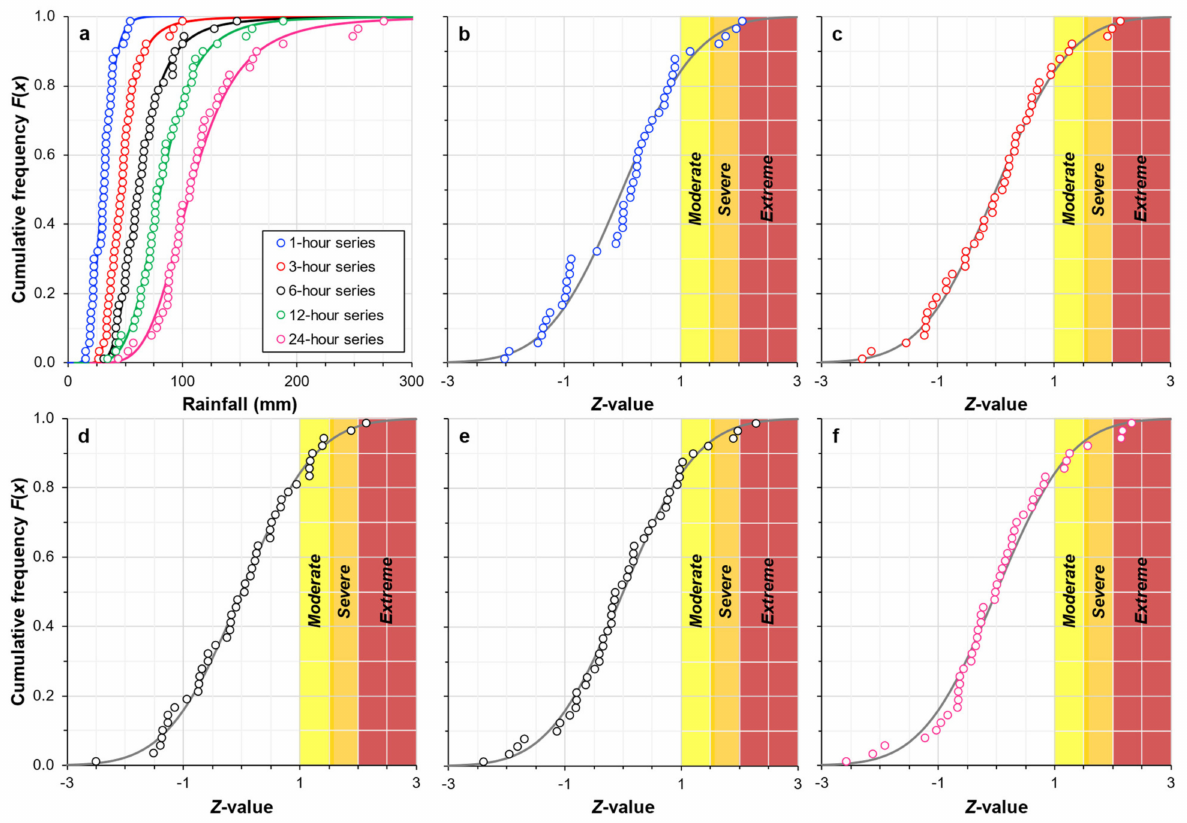
Figure 13. ( a ) Three-parameter lognormal (1-h rainfall series; R1 rain gauge) and loglogistic (3-, 6-, 12- and 24-h rainfall series; R1 rain gauge) cumulative distribution functions. ( b – f ) Standardized series of the annual maxima of rainfall (1–24 h) (see Figure